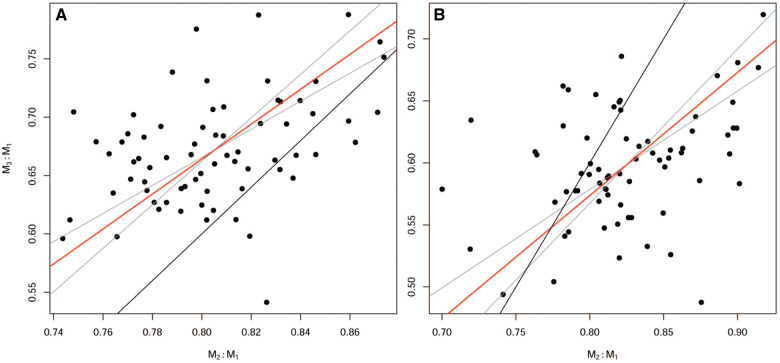
Plot of relative molar size of specimens of P. gossypinus in terms of (A) length and the MMC; (B) area and the ICM. Red line surrounded by gray CIs indicates the best fit RMA regression line explaining variance in the data. Black line indicates the regression line predicted by the MMC and ICM, respectively.